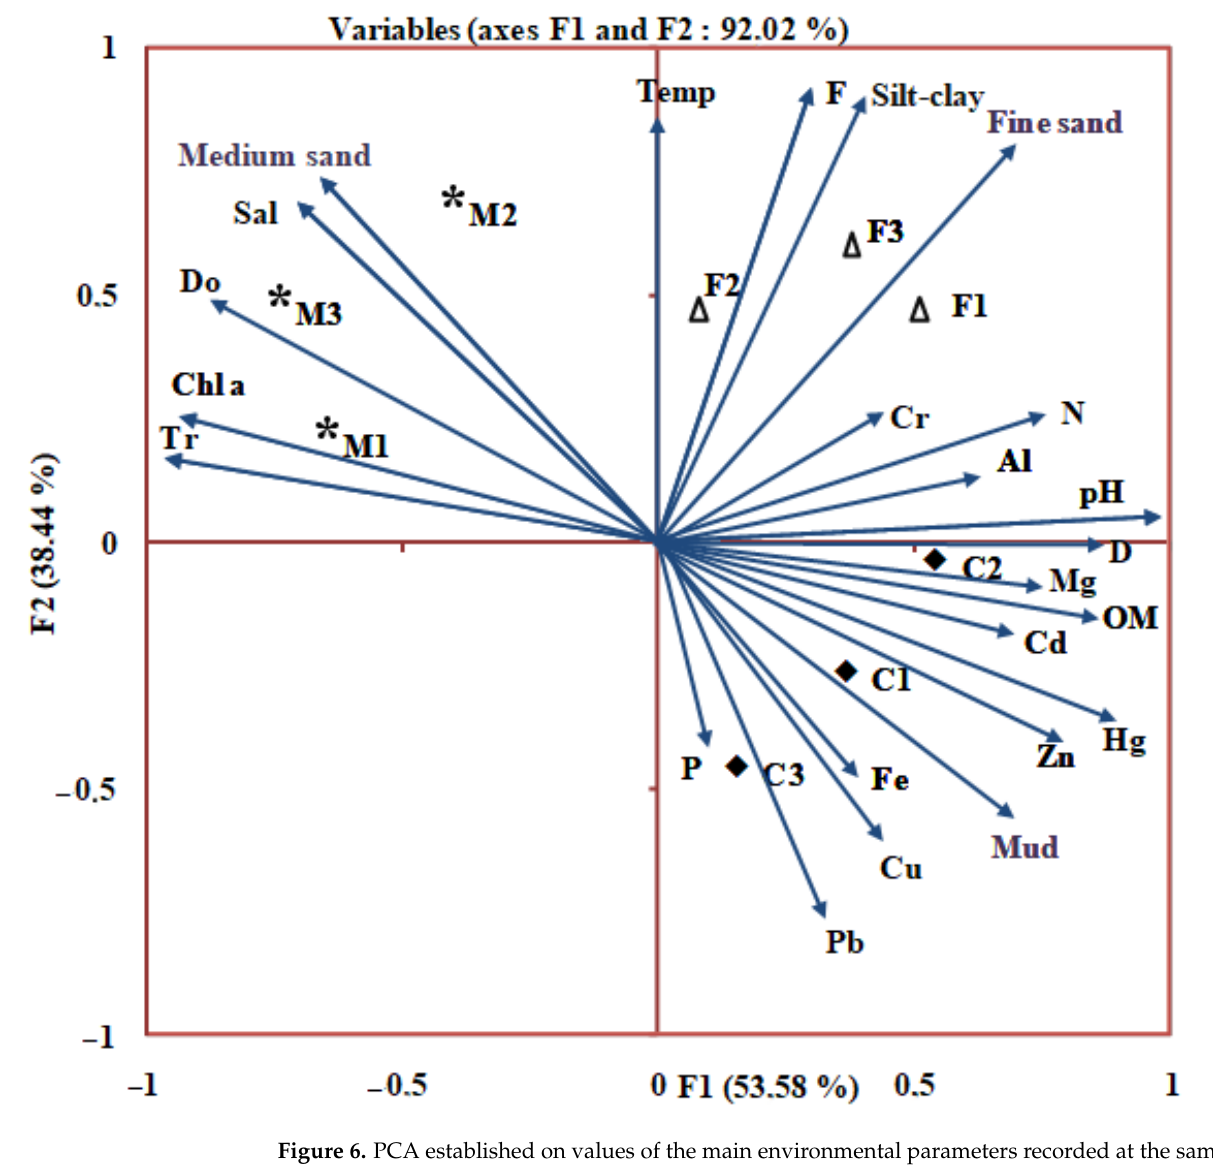
Figure 6. PCA established on values of the main environmental parameters recorded at the